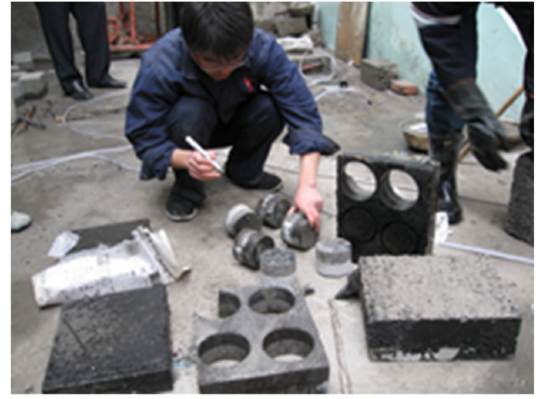
Figure 4. Drilling cylindrical specimen.